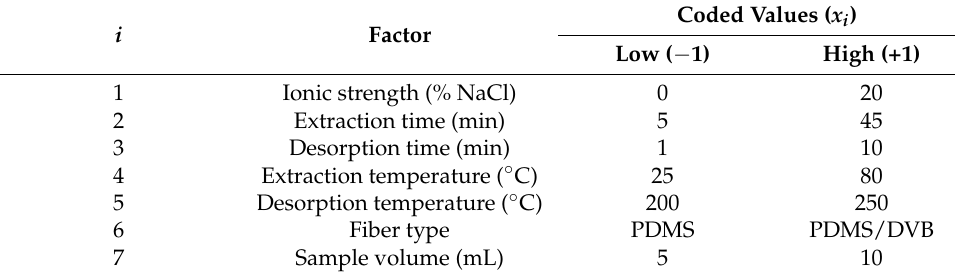
Table 1. Experimental factors and coded levels for the proposed screening approach.